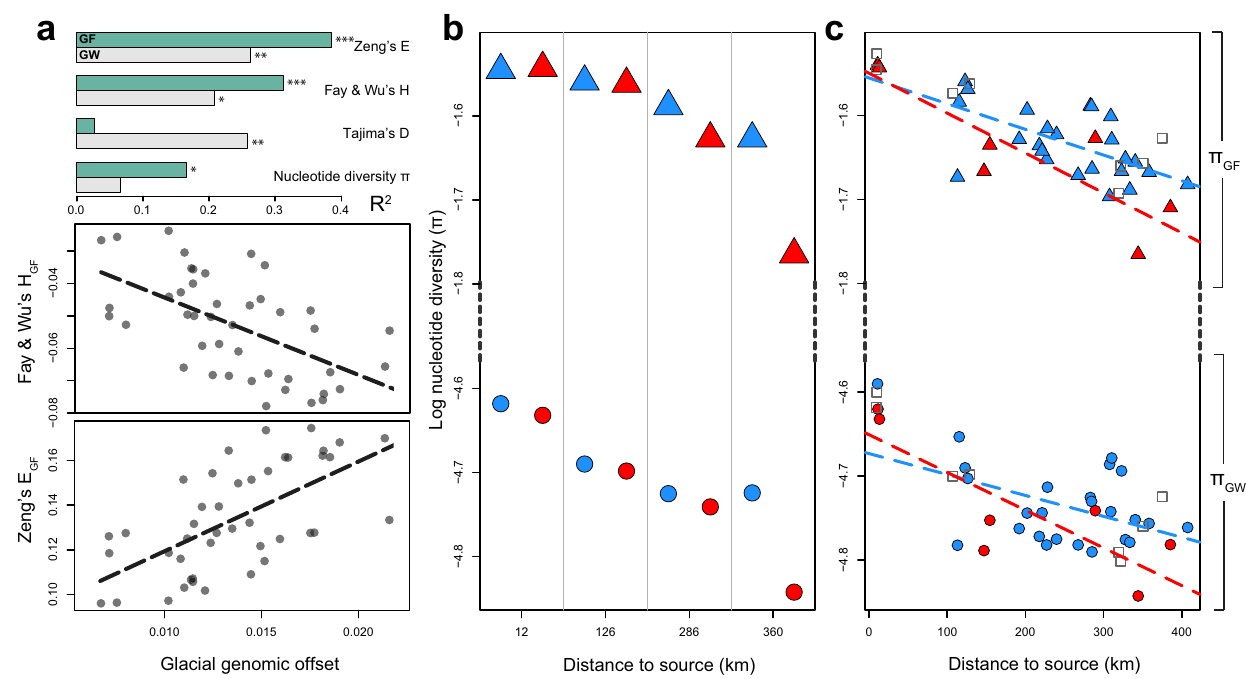
Fig. 6 | Population genetics validate glacial genomic offset predictions. A Top panel:Goodness-of- fi t(adjusted R 2 )estimatesforthecorrelationofglacialgenomic offset with select population genetic diversity and neutrality statistics (linear regressionmodels; n =43populations; p -valuethreshold:*0.01,**0.001, ***0.0001; F-test for linear regression). Model goodness-of- fi t (bars) are shown for mean per- site statistics calculated genome-wide ( GW ; grey bars) and weighted by the R 2 of sites ’ environmental association ( GF ; green bars). Signi fi cant correlations with Fay and Wu ’ s H GF (middle panel) and Zeng ’ s E GF (bottom panel) describe an excess of high-frequency, derived variants - characteristic of selective sweeps - with